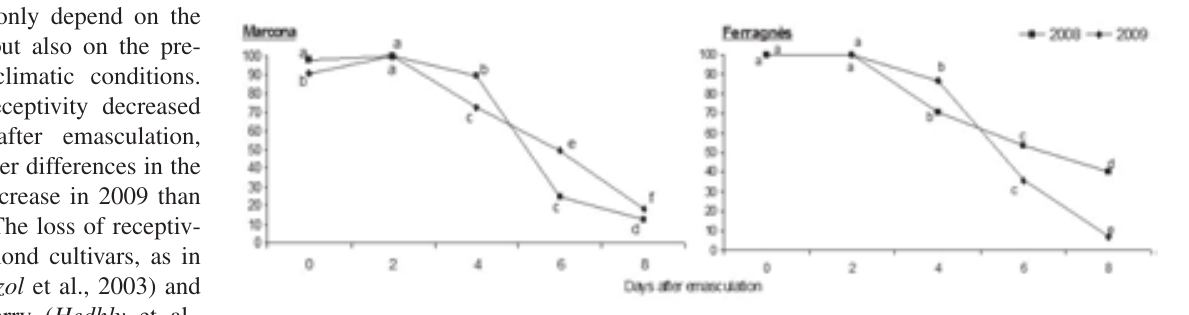
Figure 5. Percentage of pistils with pollen grains on the stigma 24 h after each pollination date in the studied cultivars over two consecutive years. Different letters indicate differences between pollination times in each year ( P <